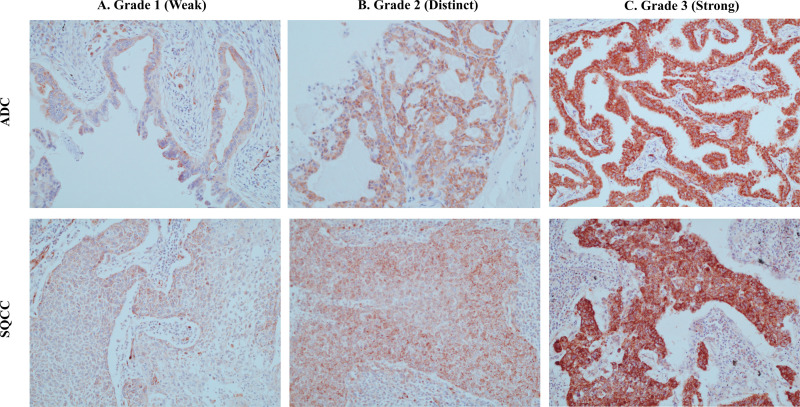
Representative examples of immunohistochemical staining for romo1 with different histologic scores (H scores).